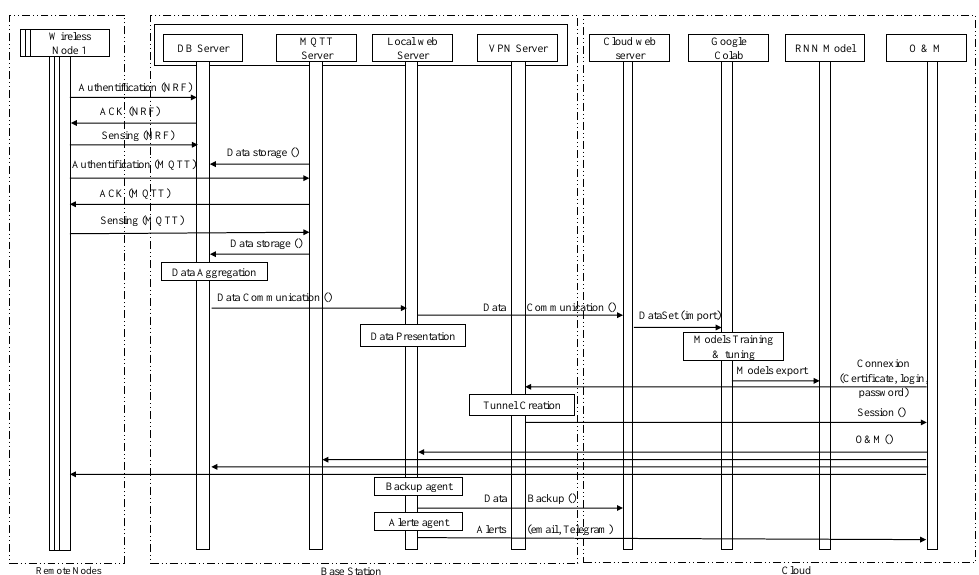
Figure 9. The network’s communication